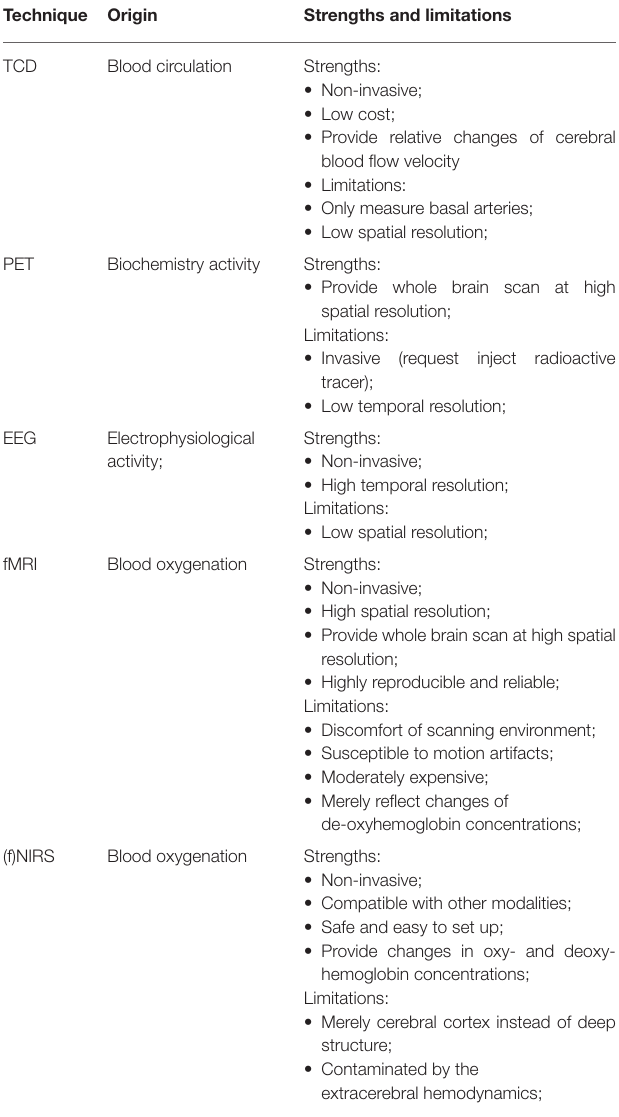
TABLE 1 | Comparison between neuroimaging modalities (10, 32, 34). Technique